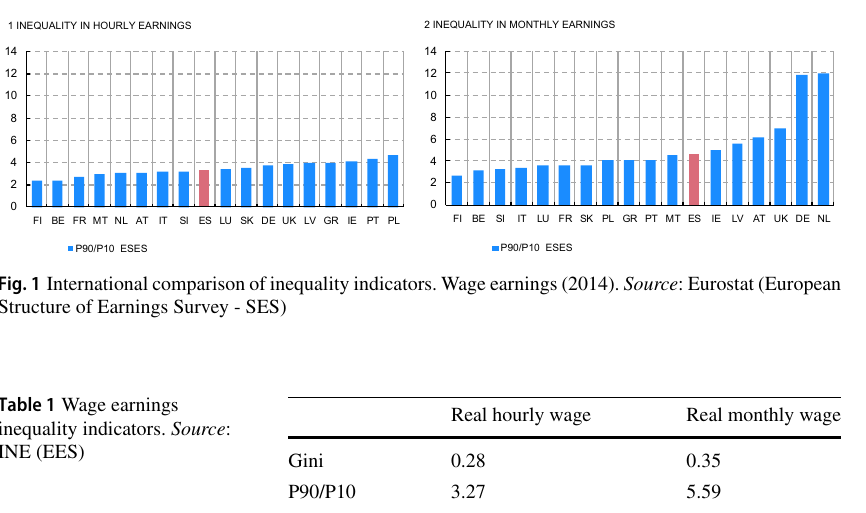
Table 1 Wage earnings inequality indicators. Source : INE (EES)